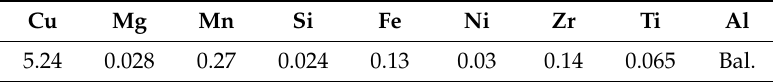
Figure 1. Tensile specimen size (unit: mm).